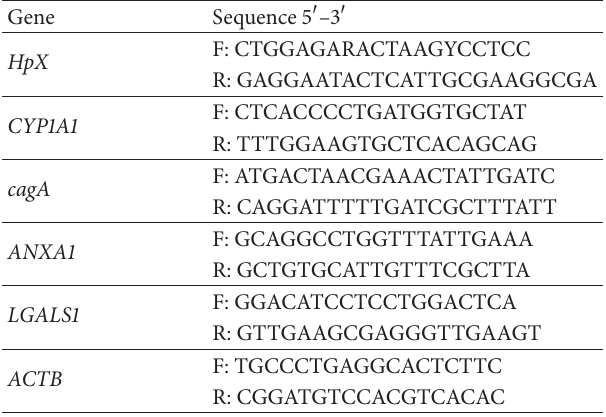
Table 1: Primers sequences used in multiplex PCR to determine H. pylori infection and cagA genotype and in q-PCR